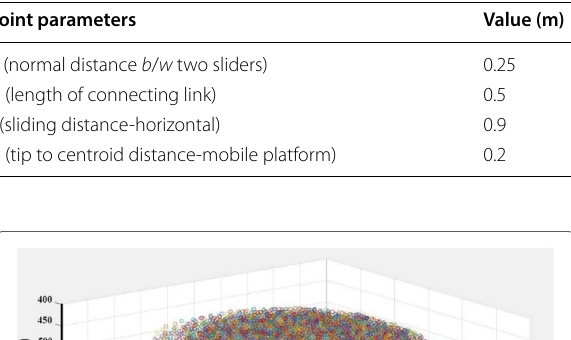
Table 2 Link dimensions after optimisation